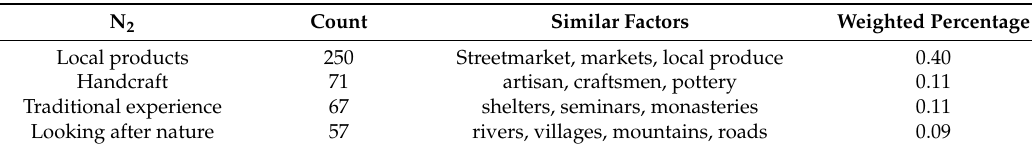
Table 11. Neutral tweets examples. Table 10. Results for N 2 for environment factors identification.